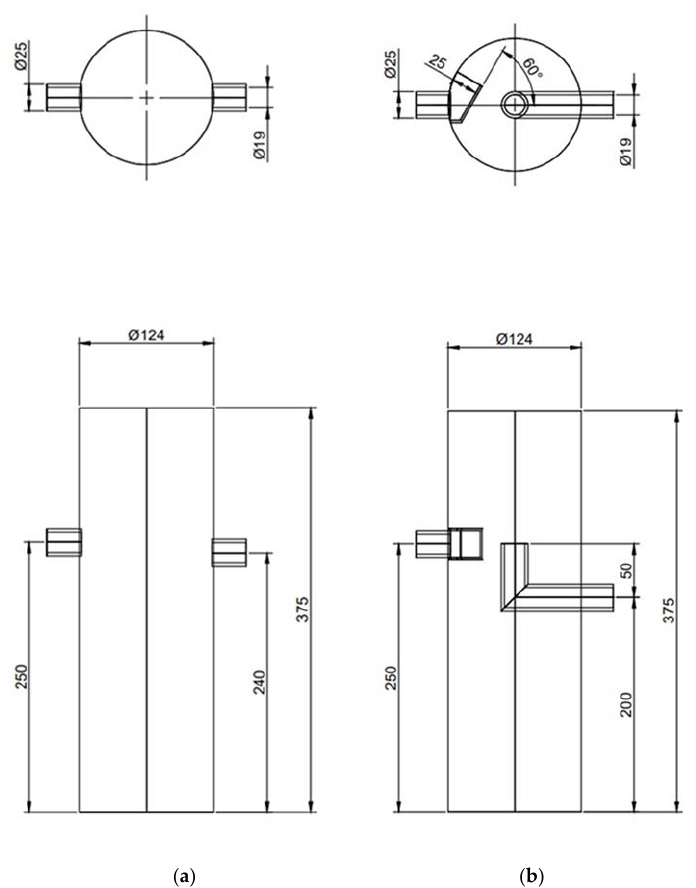
Figure 1. The structure and dimensions of the sedimentation tanks. ( a ) OS standard sedimentation tank; ( b ) OW swirl sedimentation